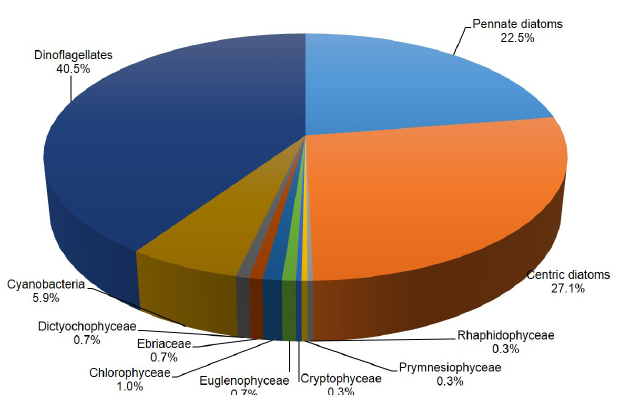
Figure 2. Distribution of major taxonomic groups of phytoplankton in the coastal and shelf waters of the northern part of the Yucatan Peninsula, southeastern Gulf of